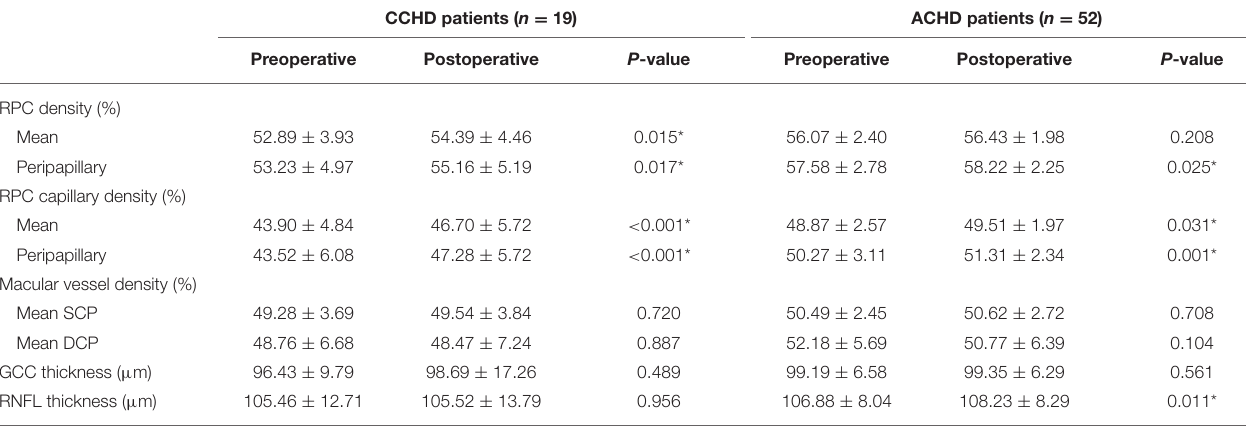
TABLE 4 | Comparison of retinal vessel density before and after surgery in CCHD and ACHD patients.